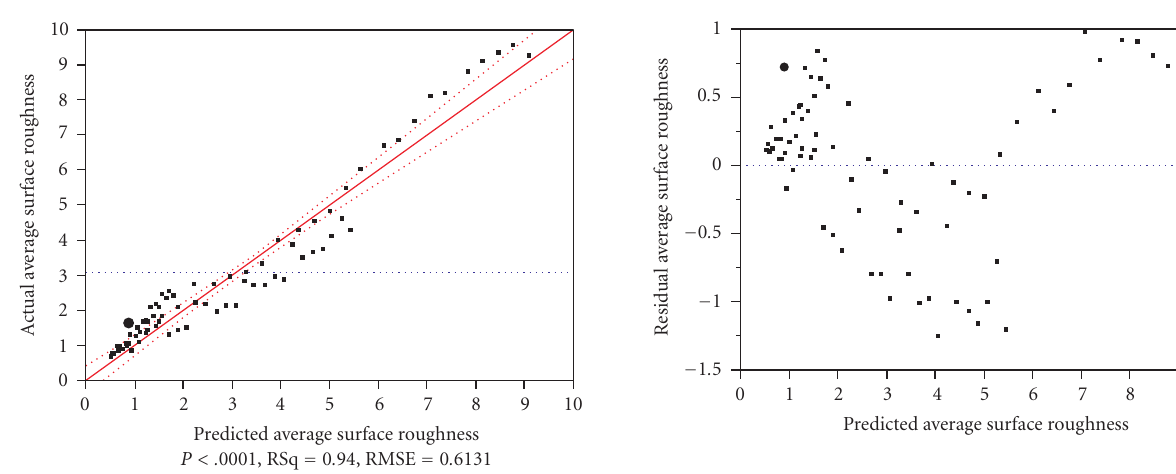
Figure 8: The residual surface roughness versus predicted surface roughness of main e ff ects and interaction terms model.